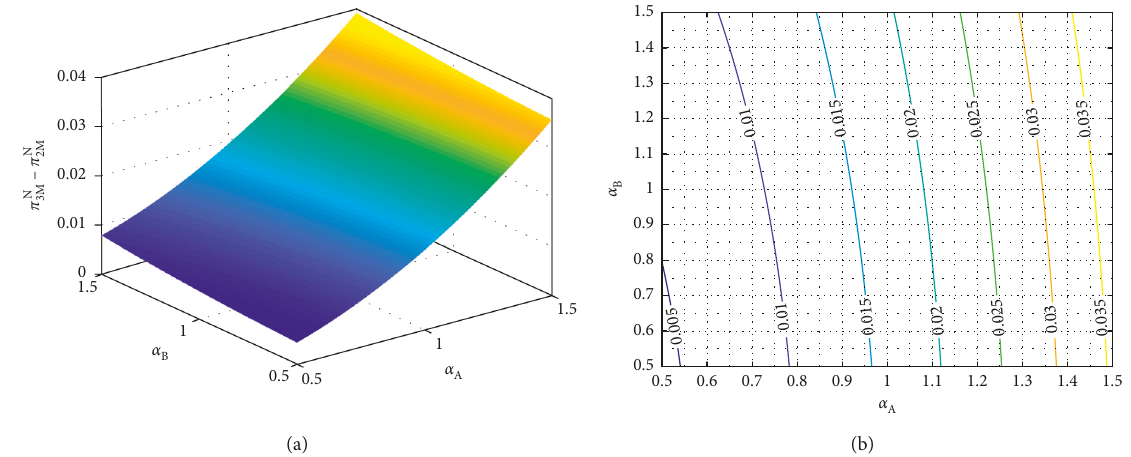
Figure 12: Impact of subsidy on supplier: (a) profit increment of supplier; (b) contour map.